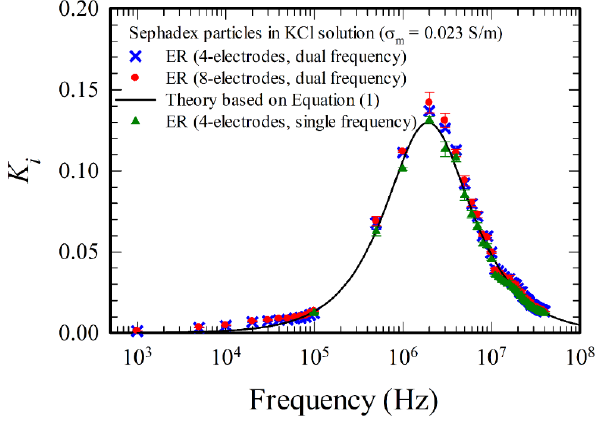
Figure 6. Comparison of the measurements with the theory based on Equation (1), using sephadex particles in KCl solution.